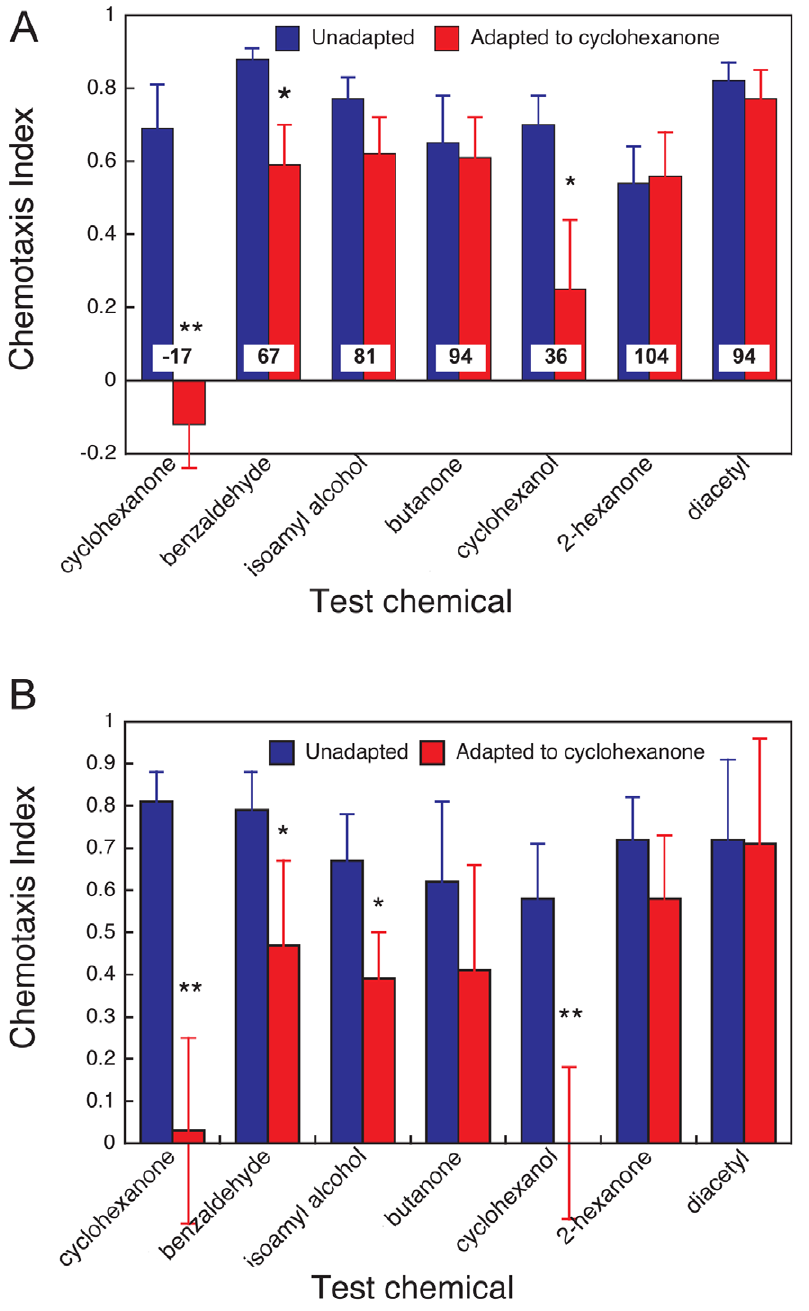
Figure. 4. Cyclohexanone receptor selectivity probed by odour adaptation. Wild-type N2 worms were adapted to 1 m l of 1/10 (A) or undiluted (B) cyclohexanone for 60 minutes prior to chemotaxis to the specified odorants being measured. Control worms were treated identically except that odorant was not present during the adaptation period. Dilutions of test odorants were: cyclohexanone 1:100, benzaldehyde 1:100, isoamyl alcohol 1:100, cyclohexanol 10 mg/ml, butanone 1:1000, diacetyl 1:1000. Bars represent the mean 6 sem of at least six independent assays. Statistics: * p , 0.05 and ** p , 0.01 comparing the mean of adapted to the mean of unadapted nematodes. Numbers (A) indicate the adapted response as a percentage of the control, unadapted response to the test odorant.